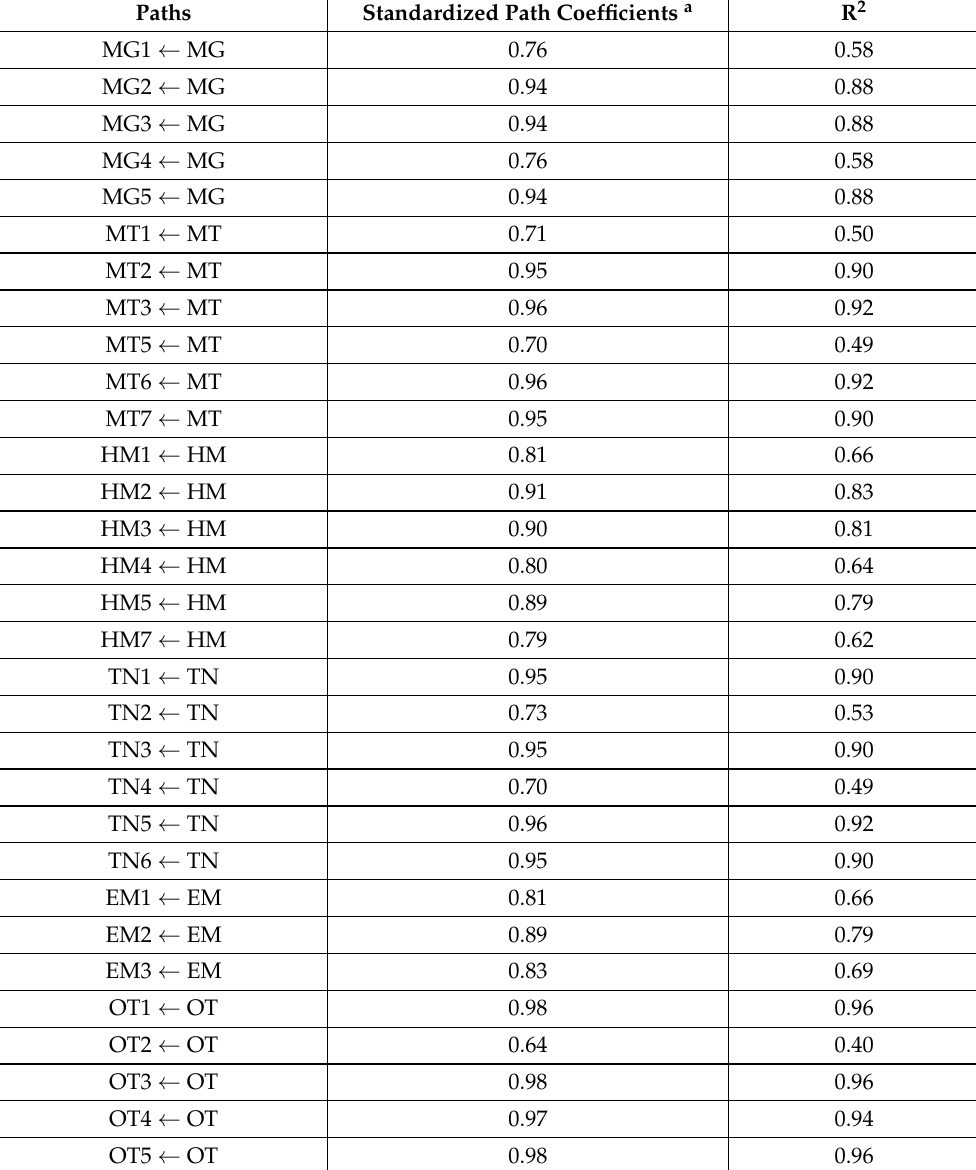
Table 5. Coefficients of standardization and R 2 values of the variables.